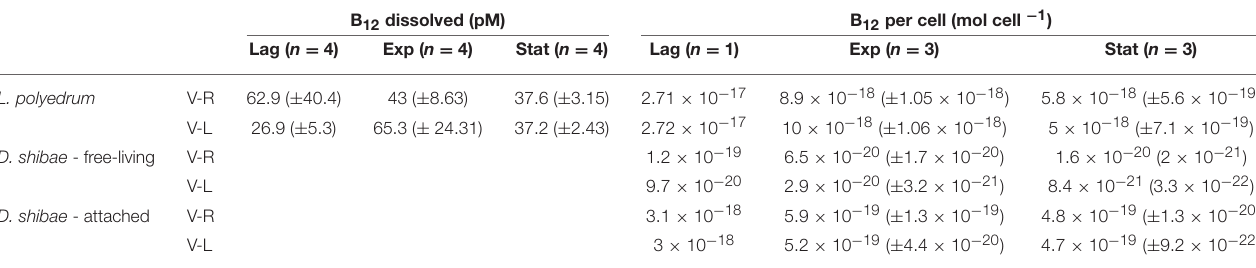
TABLE 2 | Dissolved and B 12 quotas expressed per cell (mol cell − 1 ) for L. polyedrum and D. shibae in co-culture.